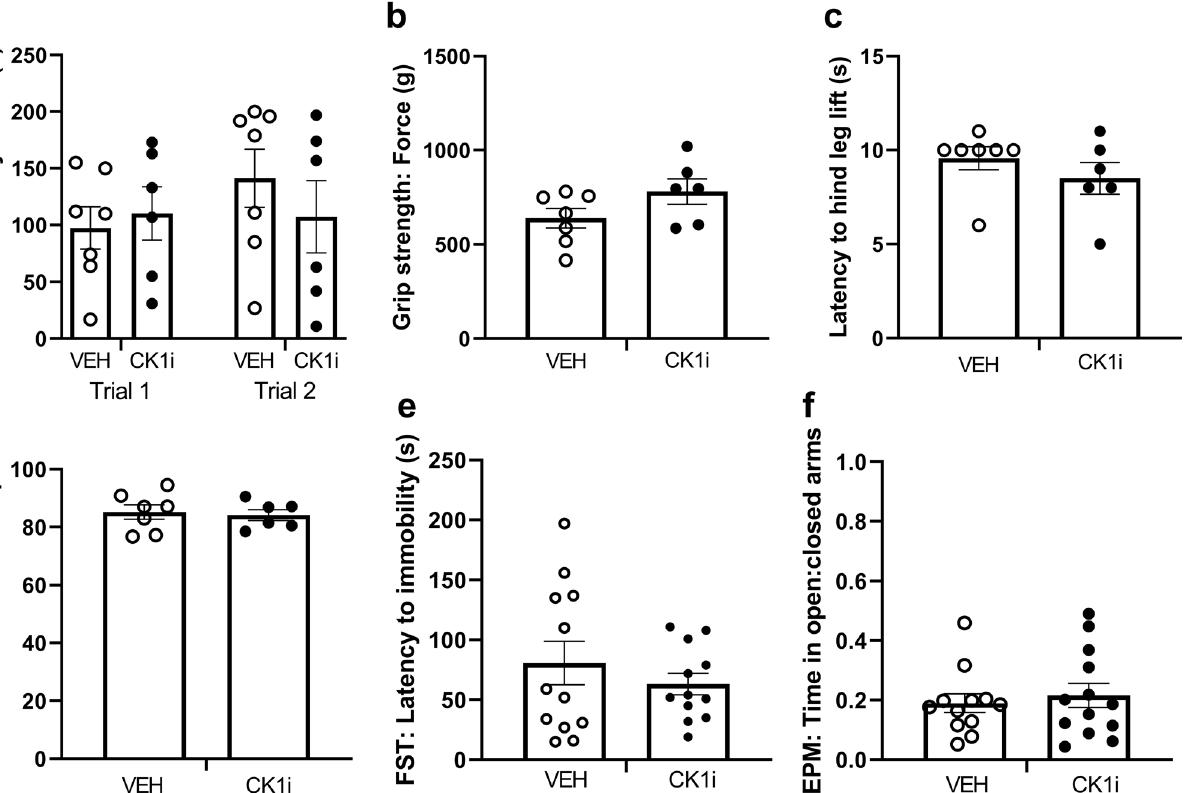
Figure 2. Chronic, short-term treatment with PF-670462 causes no obvious behavioral deficits. ( a ) Latency to fall from Rotarod over two trials (VEH: n = 7 mice, CK1i: n = 6 mice). ( b ) Forelimb grip strength, presented as the average of three trials per mouse. (VEH: n = 7 mice, CK1i: n = 6 mice). ( c ) Latency (s) to hind leg lift on hot plate. (VEH: n = 7 mice, CK1i: n = 6 mice). ( d ) Percent preference for a 2% sucrose solution over water in a two bottle, overnight test. (VEH: n = 7 mice, CK1i: n = 6 mice). ( e ) Latency (s) to first bout of immobility in the forced swim test (VEH: n = 12 mice, CK1i: n = 13 mice). ( f ) Ratio of time in the open:closed arms of the elevated plus maze. (VEH: n = 12 mice CK1i: n = 13 mice) Each dot represents a mouse. Data are represented as mean ± SEM.